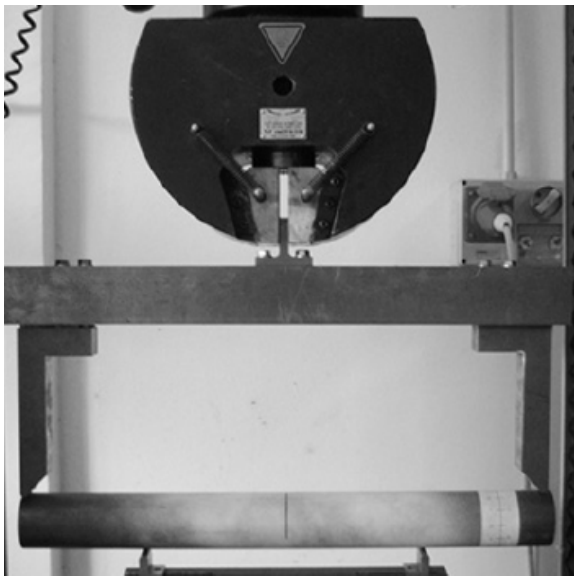
Figure 1: Four point bend test set-up.